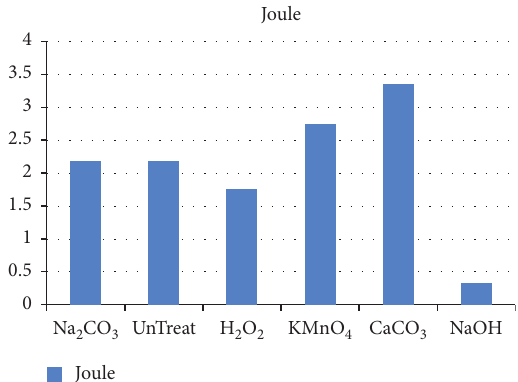
Figure 4: Impact strength (Joule) vs. treated and untreated SGFs with polyester.